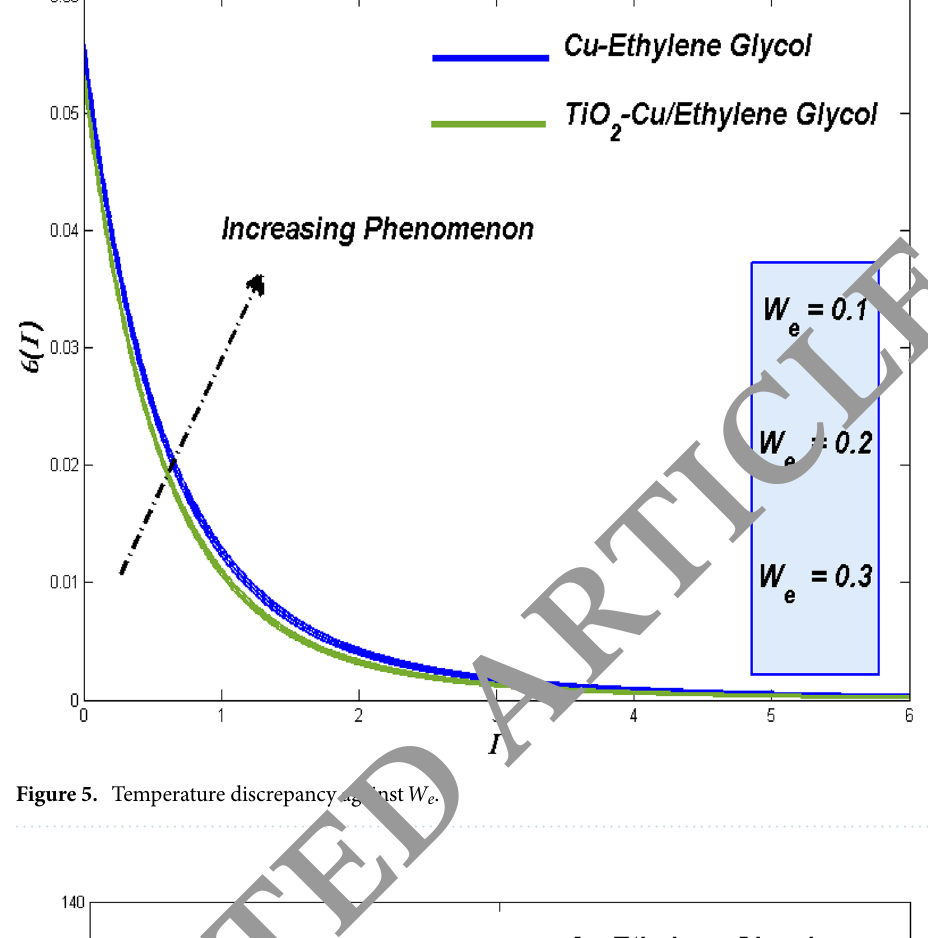
Figure 5. Temperature discrepancy against W e .